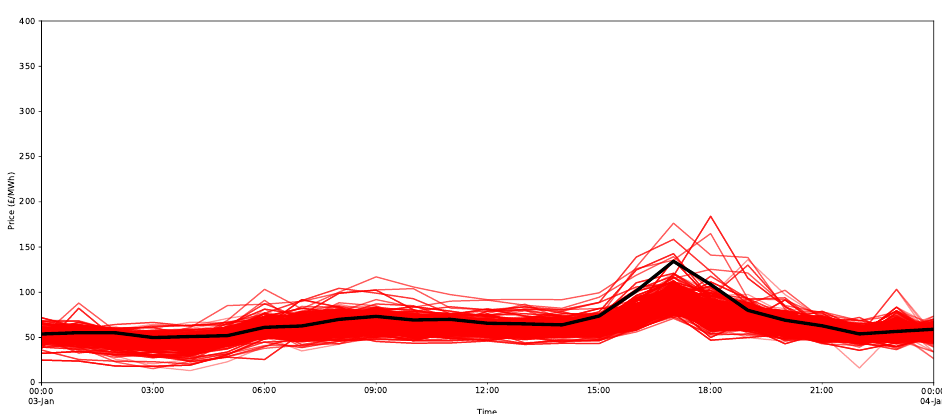
Figure 25. All 2000 bootstrap ensembles (red) for the ARX method for 3 January 2019. The true price is in black.